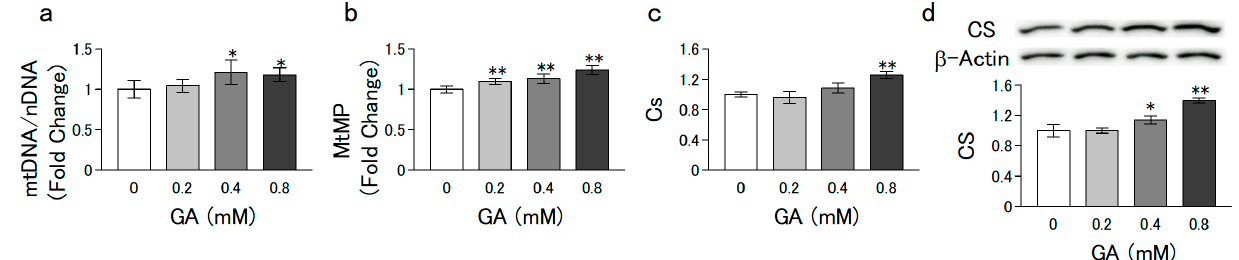
Figure 2. E ff ect of GA on mitochondrial biogenesis in C2C12 cells. C2C12 cells grown to subcon fl u- ence in a growth medium (without GA) were further cultured in di ff erentiation medium with or without GA for 6 d. ( a ) Relative mtDNA copy number measured using qPCR. Results are shown as fold change values compared with the results of the control group. ( b ) MtMP measured via Rho123 uptake. Results are shown as fold change values compared with the results of the control group. ( c ) mRNA levels of Cs . The mRNA levels were measured using qPCR. ( d ) Western blot images of CS and β -actin, the internal control. Values are presented as mean ± SD of three independent experi- ments. Data were analyzed using a one-way ANOVA followed by Dunne tt ’s post hoc comparison tests. Mean value was signi fi cantly di ff erent from that of the control: ** p < 0.01, * p < 0.05.